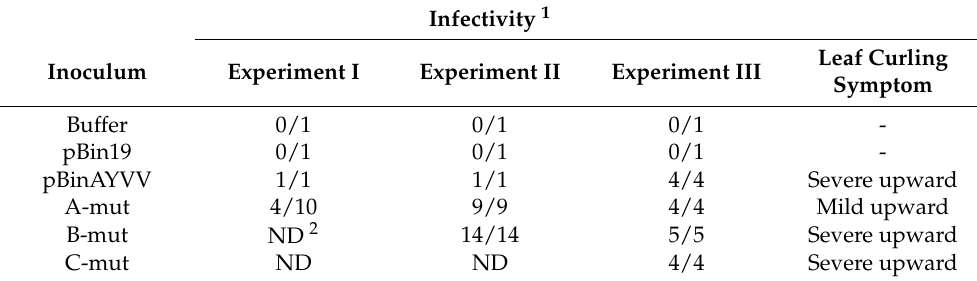
Table 2. Infectivity of infectious constructs of AYVV-NT harboring different mutations in C4 protein on N. benthamiana